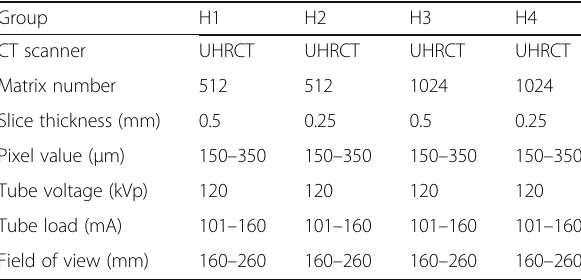
Table 2 Imaging conditions for the four spatial resolution groups with UHRCT with different matrix numbers and slice thicknesses for the human tibia